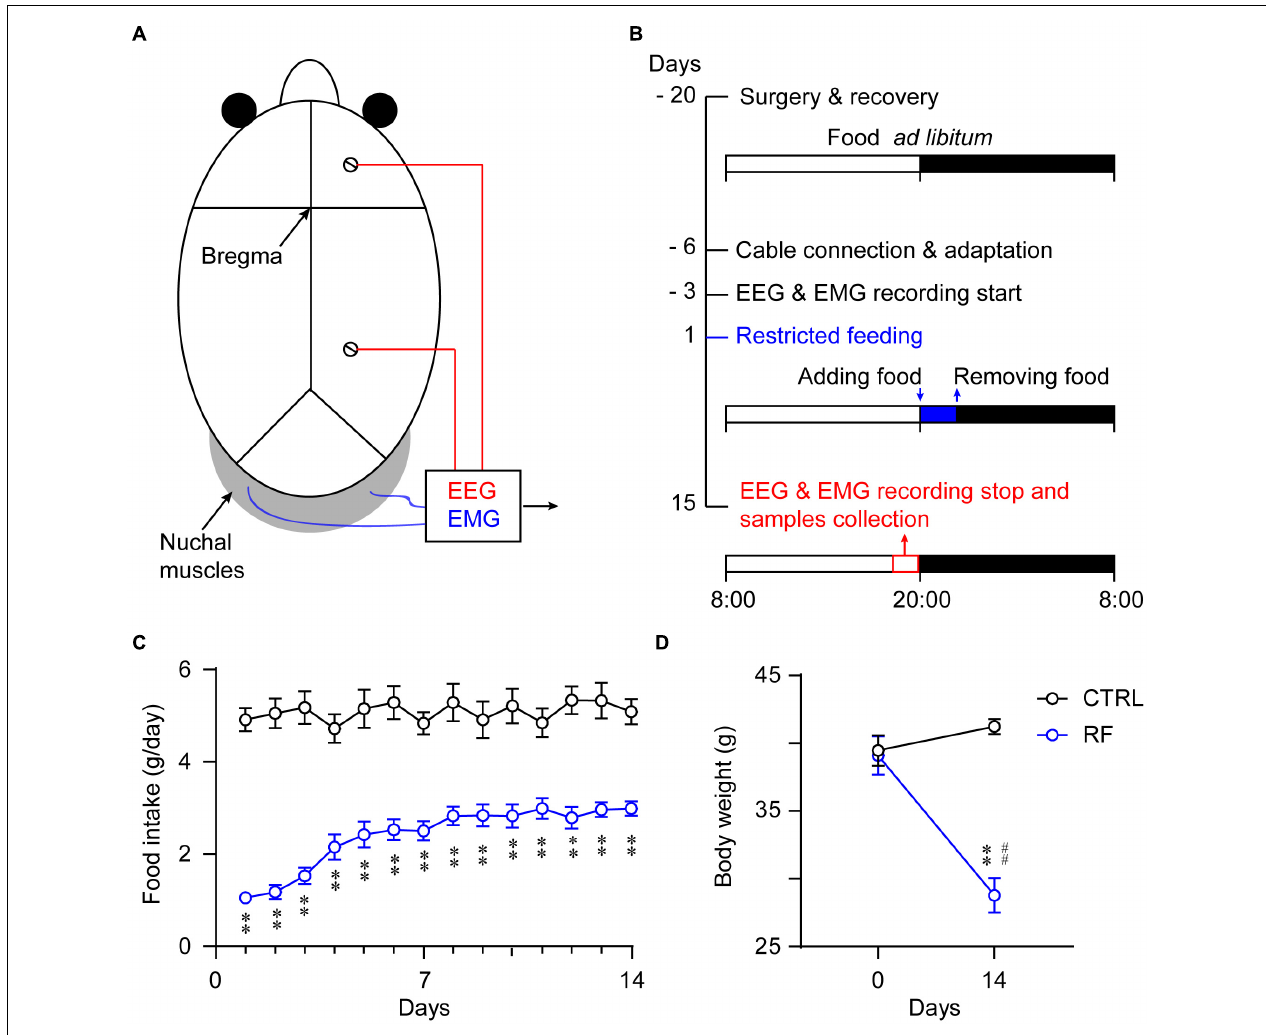
FIGURE 1 | Experimental schedule and measurement of food intake and body weight. Schematic diagram showing the placement of the electrodes for the EEG/EMG recordings (A) . Illustration of the RF protocol used in the current experiment. The vertical axis indicates the experimental day, and the horizontal axis represents the manipulation each day. The mice in the RF group had access to food 2 h per day during the 14-day period (B) . Food consumption per day of the mice in the RF group and control group ( ad libitum access to food) during the 14-day period (C) . Body weight changes in the RF group versus the control group before and after food restriction (D) . ∗∗ p < 0.01 versus CTRL; ## p < 0.01 versus before food restriction, n = 10. CTRL, control; RF, restricted